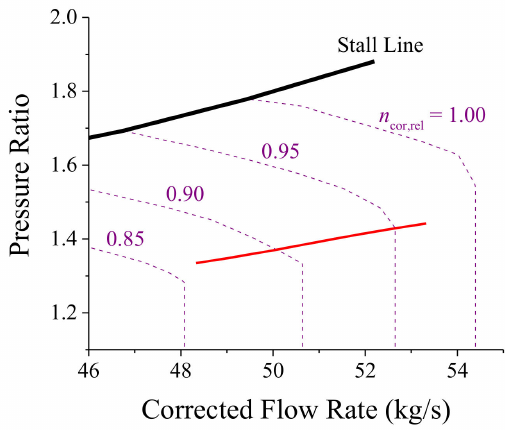
Figure 5. Matched Operating Line of AFS vs. Flight Mach